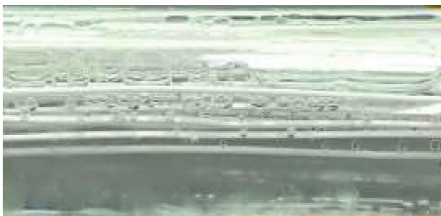
Figure 3: Bubbles appeared during the NOx removal experiment.